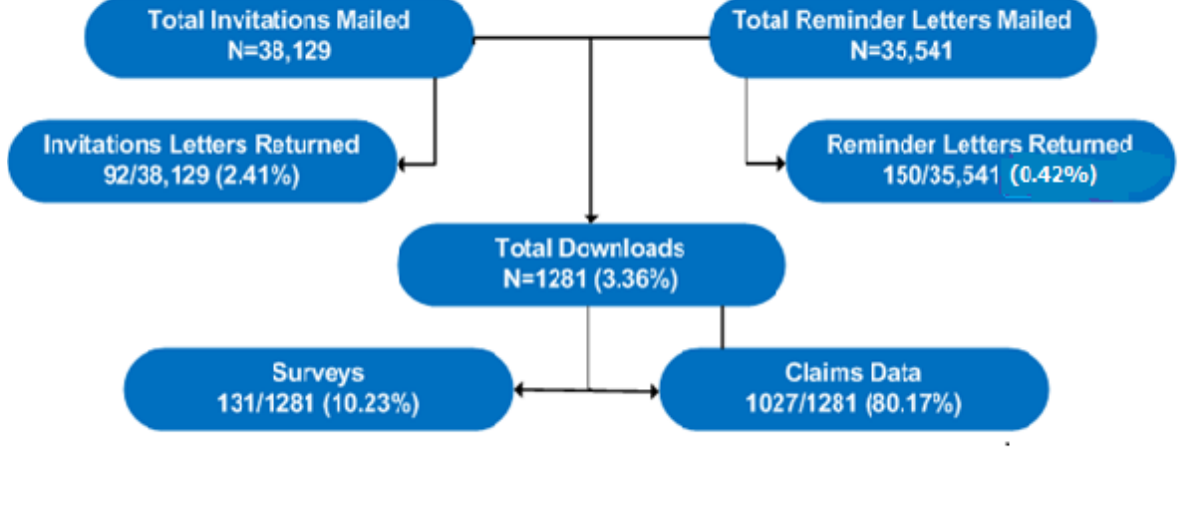
Figure 1. Study participation subgroups. Claims data were available for 1027 of the 1281 download participants’ data due to a change in Express Scripts Incorporated (ESI) policy during the study